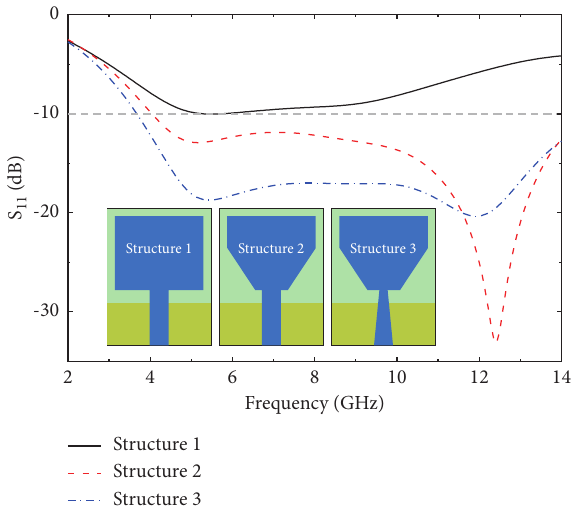
Figure 2: Simulated S 11 results of three UWB antenna structures.